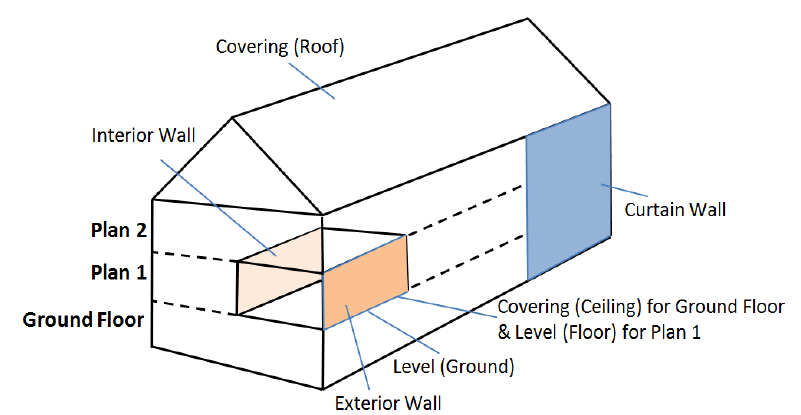
Figure 5. Covering, level and wall